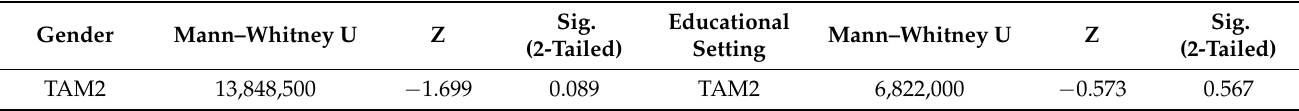
Table 8. Effect of educational setting and gender on the TAM2 results.